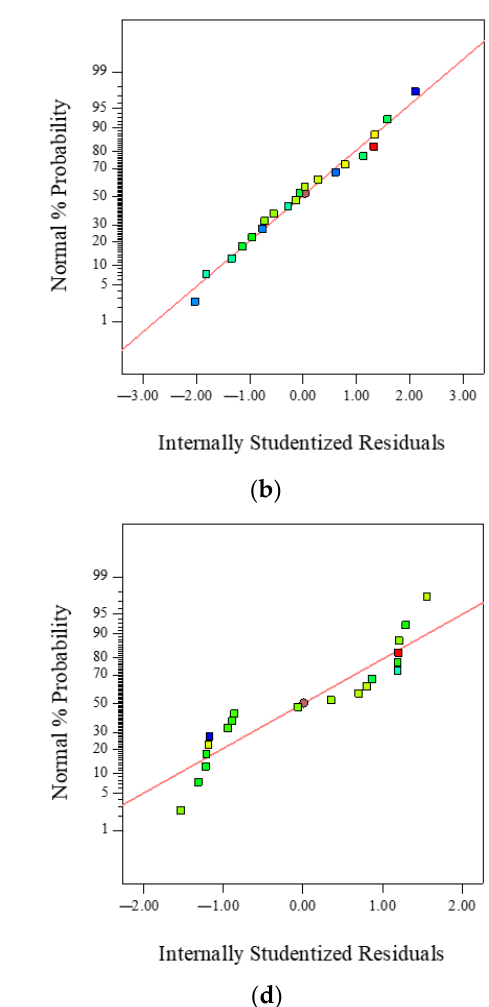
Figure 5. Diagnostics of responsive model: ( a ) AV ; ( b ) MS ; ( c ) STS ; and ( d ) FTS .